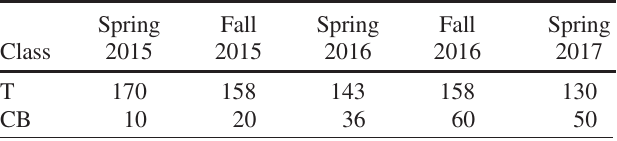
TABLE I. The enrollment data for the competency-based (CB) and the traditional (T) classes. The T course was based on lectures, recitations, and multiple choice examinations. The CB model provided the scope for individualized learning.